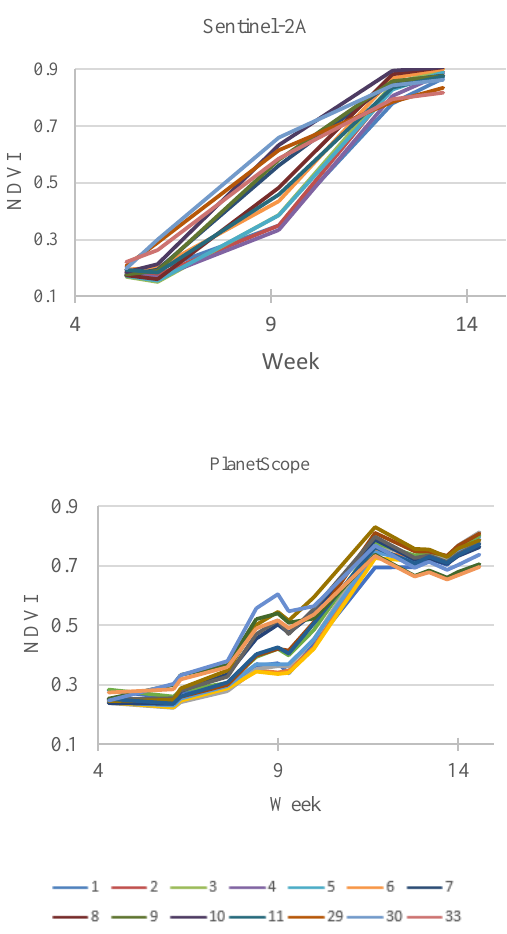
Figure 11. Variation of NDVI over the 2017 growing season Sentinel-2A vs. PlanetScope for Lebanon